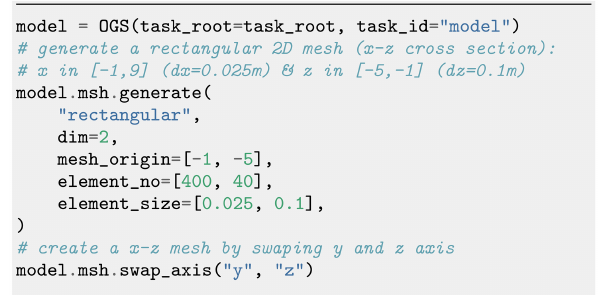
Figure 22. Initialization of an OGS model with mesh generation.